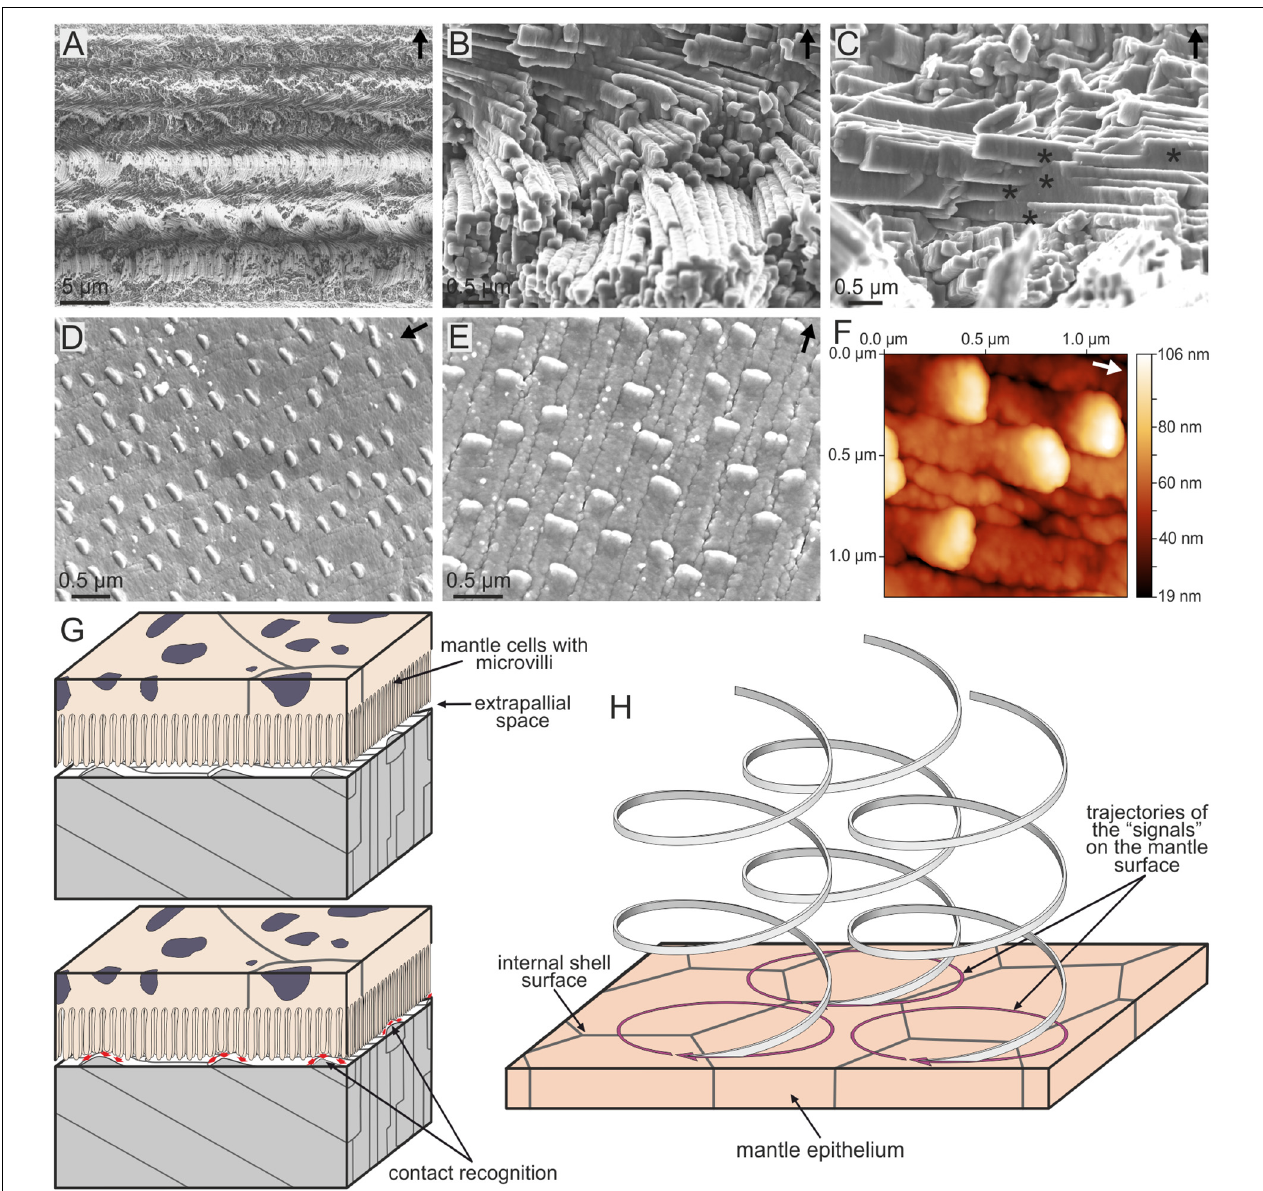
FIGURE 9 | The aragonitic helical fibrous microstructure of cavolinioidean gastropods. (A) Fracture through the shell of Cuvierina columnella . The helices coil for more than three complete turns. (B) Detail of the microstructure of Clio pyramidata . Note the close packing and the high degree of interpenetration of fibers. (C) Interpenetration of fibers (asterisks) in Creseis acicula . (D) Oblique view of the internal shell surface of Cuvierina columnella , showing the elevated anteriormost tips of fibers. (E) Plan view of the internal shell surface of Creseis clava . As in (D) , each fiber has an elevated growth tip. (F) Atomic force microscopy view (topography image) of the internal shell surface of Cuvierina columnella . The tips of fibers rise by ca. 85 nm above the surface. (G,H) Model for the secretion of spiral fibers. The upper panel in (G) corresponds to the non-secretional stage. When shell secretion resumes, the mantle cells recognize the positions of the tips of fibers in order to continue their secretion [lower panel in (G) ]. (H) In order for the spiral path to be achieved, the cells have to displace the tips of the fibers along circular trajectories. The displacement along the coiling axis is caused by the thickening of the shell. Arrows point to the external shell surface in (A–C) , whereas they